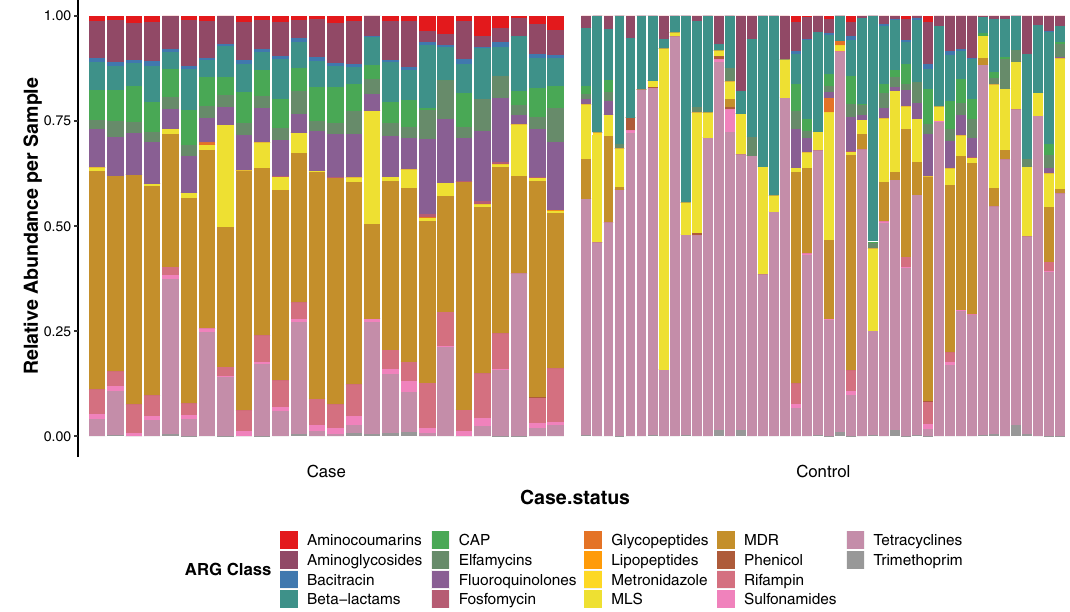
Figure 3. Relative abundance of ARGs differs in cases and controls. The relative abundance of ARGs assigned to 18 different antibiotic classes is shown with each column representing the resistome from one individual. Relative abundances were determined using raw ARG abundances that were normalized by the approximate number of genome equivalents in the sample as determined using MicrobeCensus. CAP cationic antimicrobial peptides, MLS Macrolide, Lincosamide, Streptogramin, MDR Multidrug